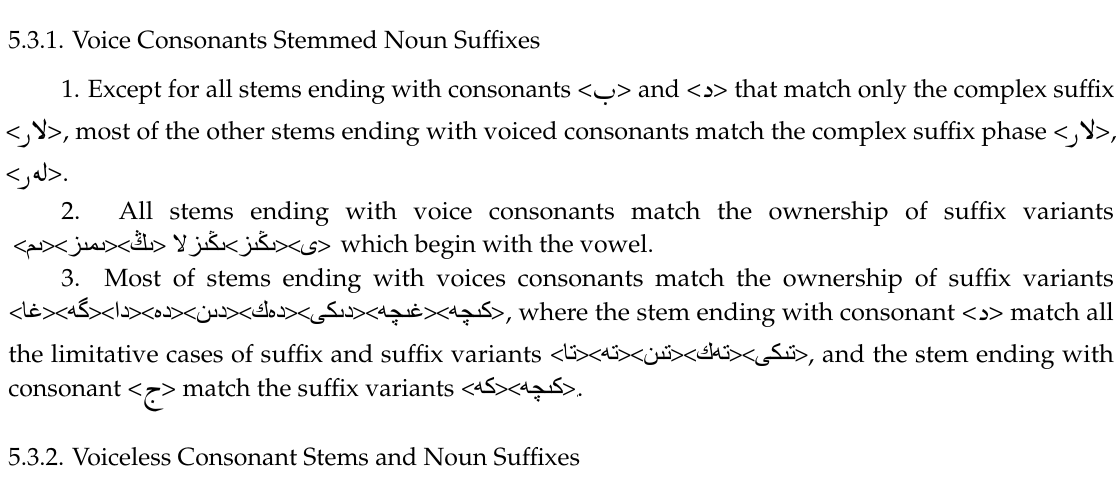
Table 5. consonants classification.